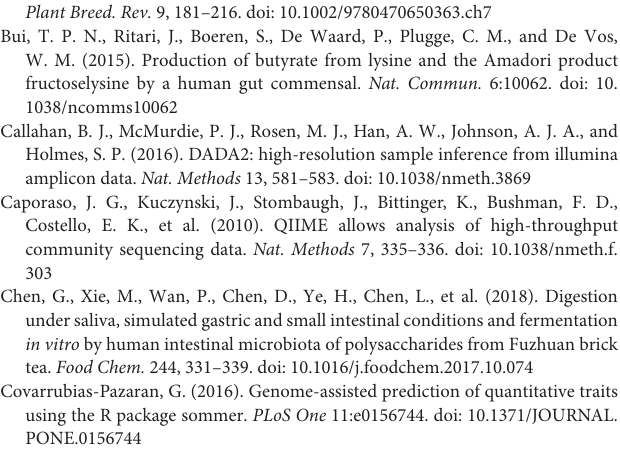
Supplementary Table 2 | Genus level table generated from 16S rRNA sequencing. Supplementary Table 3 | MetaCyc pathway enrichment raw data file from PICRUSt. Supplementary Table 4 | ASV and genus level table from 16S rRNA sequencing for FL and lysine fermentation.